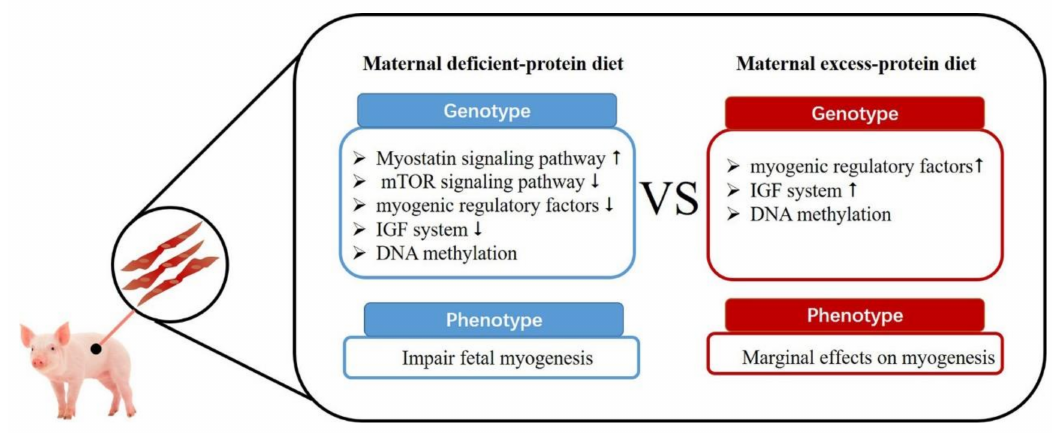
Figure 2. Effects of deficient and excess maternal protein level on fetal fiber formation. Upward-pointing arrow indicates “increase” and downward-pointing arrow indicates